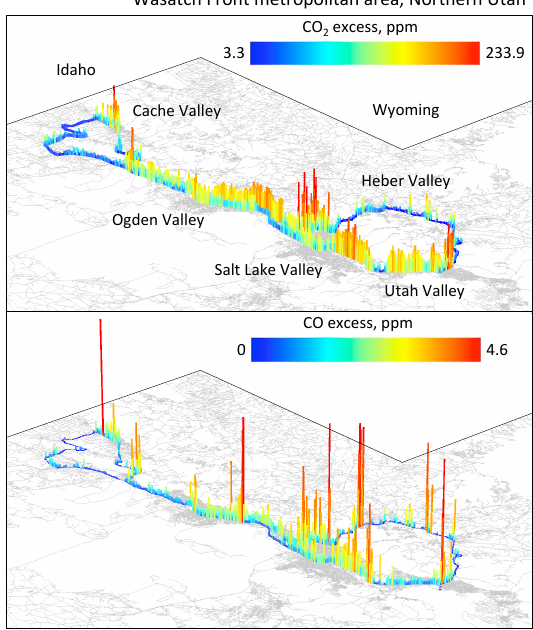
Figure 6. The CO 2 mole fraction along the Wasatch Front metropolitan area in northern Utah, USA. Values shown represent mole fraction above background mole fraction obtained from Wen- dover, Utah. The underlying black and white grid shows roads, and the color bar shows the range of values